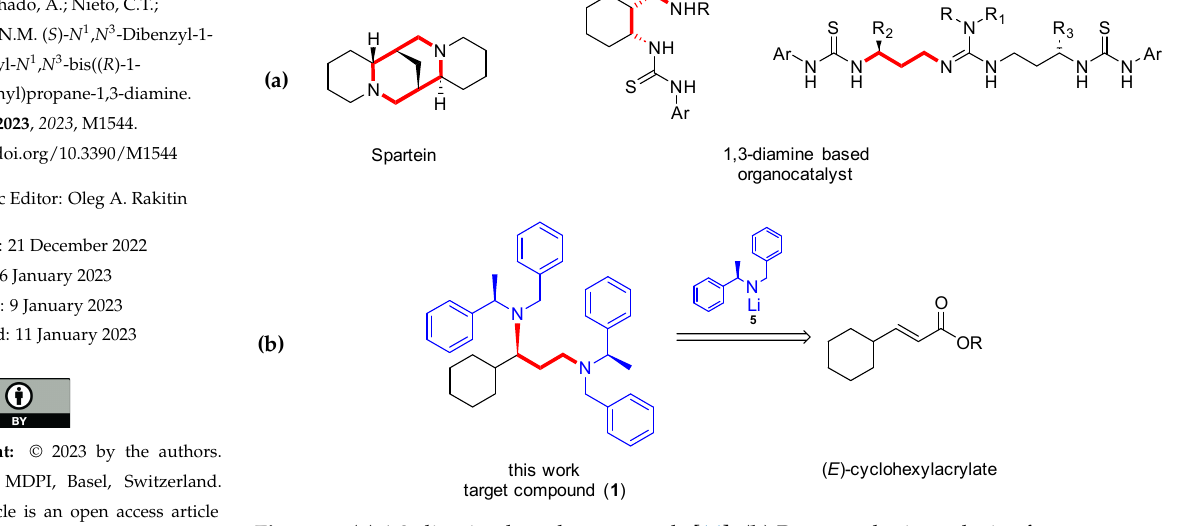
Figure 1. (a ) 1,3-diamine-based compounds [14]. ( b ) Retrosynthetic analysis of 1 . Figure 1. ( a ) 1,3-diamine-based compounds [14]. ( b ) Retrosynthetic analysis of 1